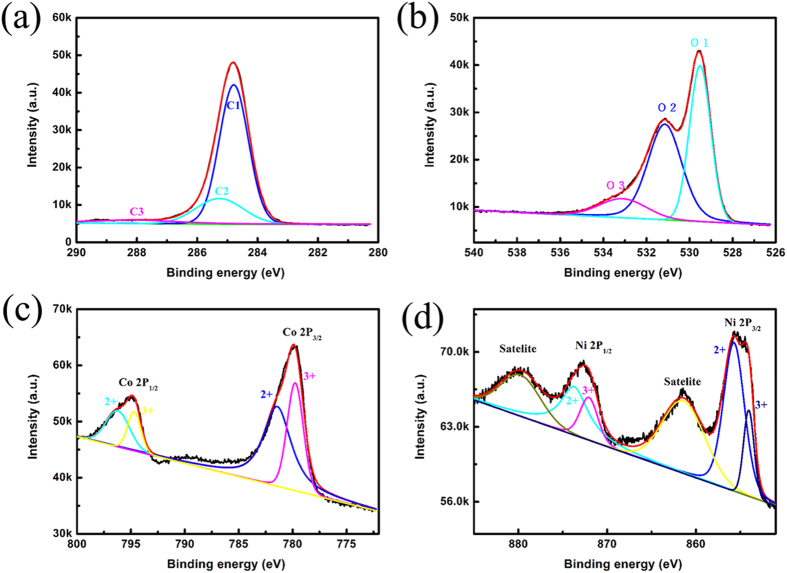
XPS spectra of the CNS/NiCo2O4 core-shell sub-microspheres:(a) C1s, (b) O1s, (c) Ni 2p, (d) Co 2p.